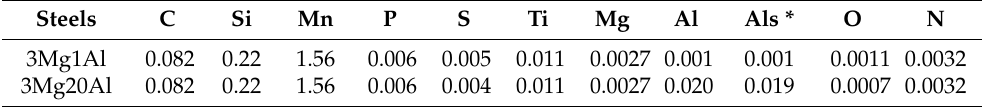
Table 1. Measured chemical compositions of steel samples (wt.%).